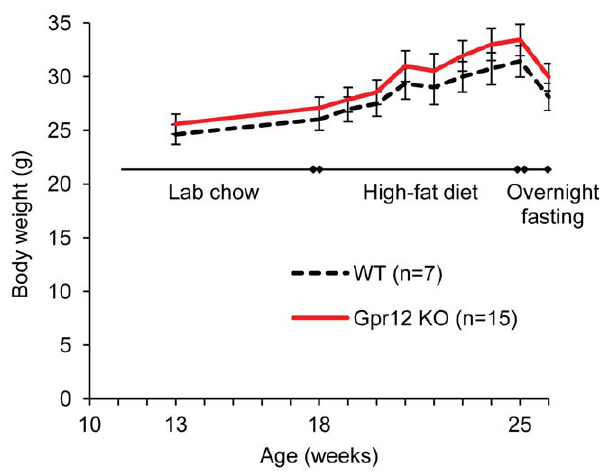
Figure 3. Body weight gain on high-fat diet. Body weight development in Gpr12 knockout (KO; n=8) mice (red line) and wildtype (WT; n=8) mice (dotted line) fed with lab chow, high-fat diet or after fasting showed no difference at any measured time point.